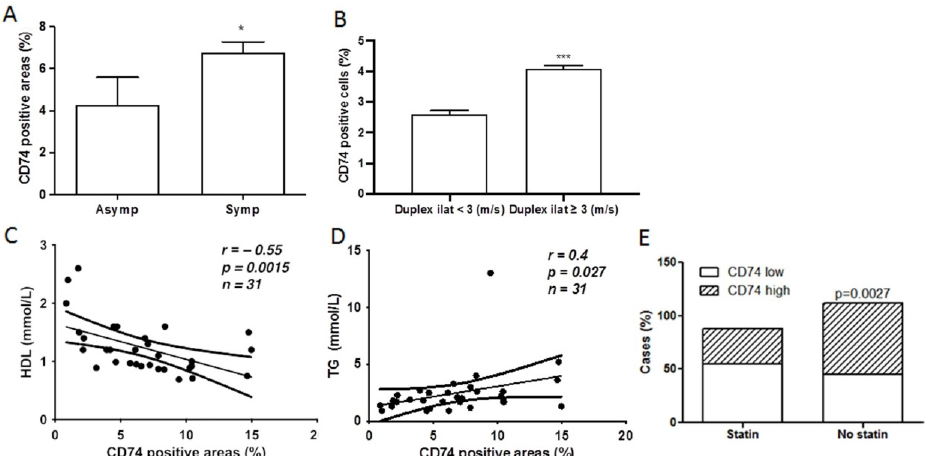
Figure 4. CD74 levels are significantly associated with clinical manifestations and serum TG, and inversely associated with HDL and statin treatment. ( A ) CD74 levels in symptomatic (Symp, n = 53) and asymptomatic (Asym, n = 8) patients. * p < 0.05 vs. asymptomatic group. ( B ) Comparatively higher levels of CD74 were seen in patients with severe carotid stenosis. *** p < 0.001 vs. duplex scan < 3 (m/s). ( C , D ) CD74 is inversely correlated to HDL levels ( C ) and positively correlated to TG ( D ). ( E ) Carotid plaques from patients without statin treatment showed higher levels of CD74 compared to those from patients who received statin treatment.